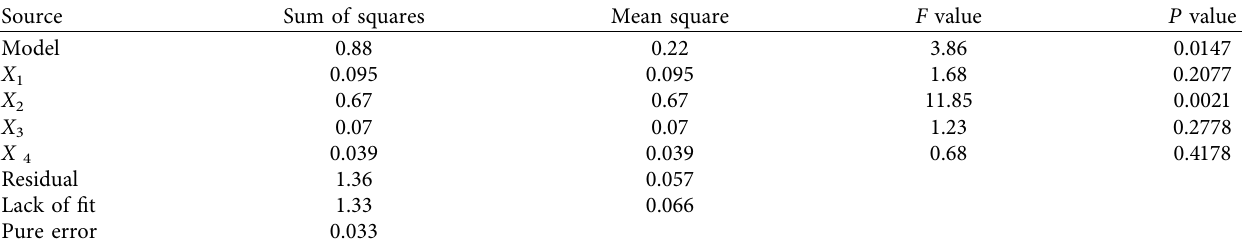
Table 4: Analysis of variance of experimental results of the linear model.